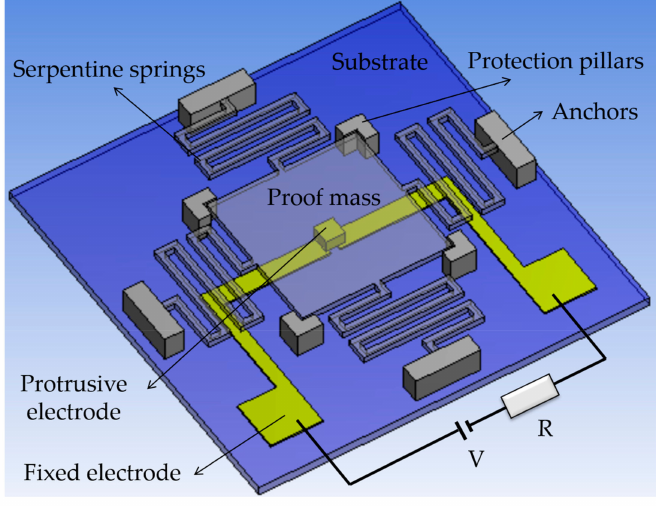
Figure 1. Scheme of the designed inertial